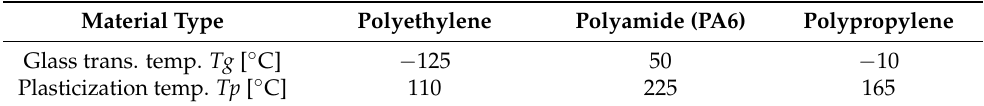
Table 4. Characteristic temperatures for the selected polymers